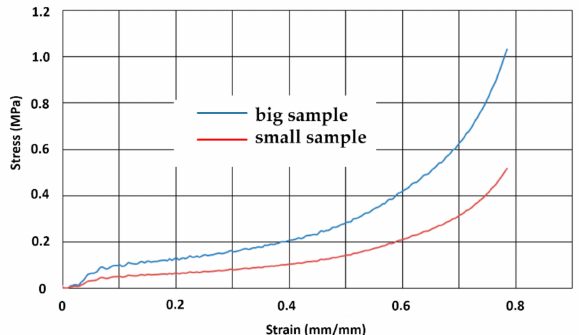
Figure 11. The stress–strain curves of big (80 mm × 80 mm, 40 mm height) and small (20 mm × 20 mm, 30 mm height) sample of EPP foam at a quasistatic loading strain rate of 2 mm/s.